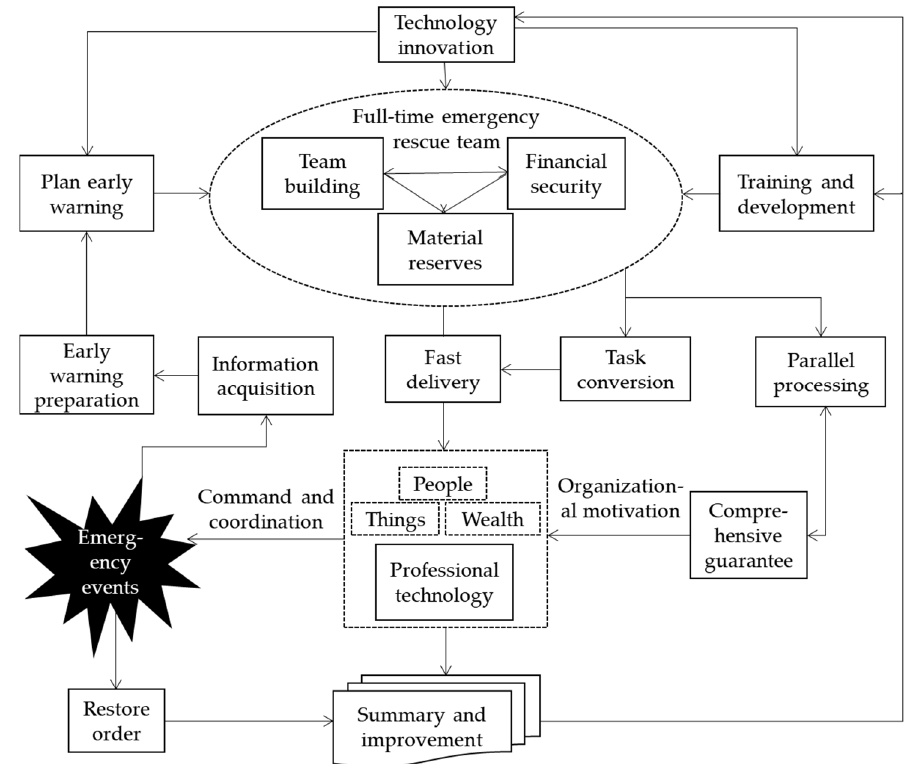
Figure 2. Spiral organizational competency model of full-time water conservancy emergency rescue teams.